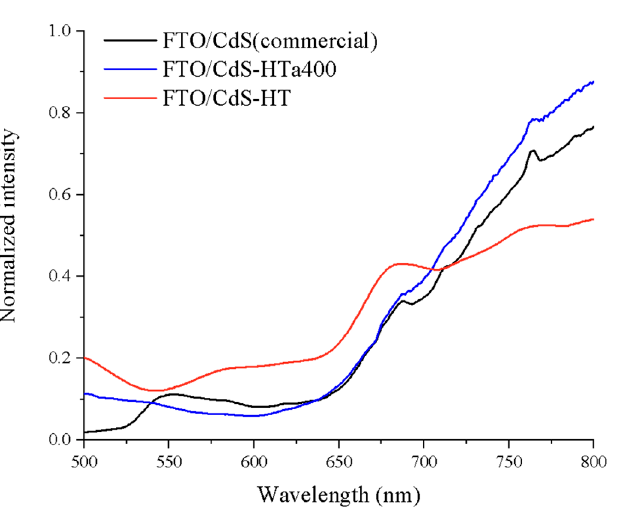
Figure 9. Photoluminescence spectra of FTO/CdS-HTa400 (blue), FTO/CdS-HT (red) and FTO/CdS (commercial, black).